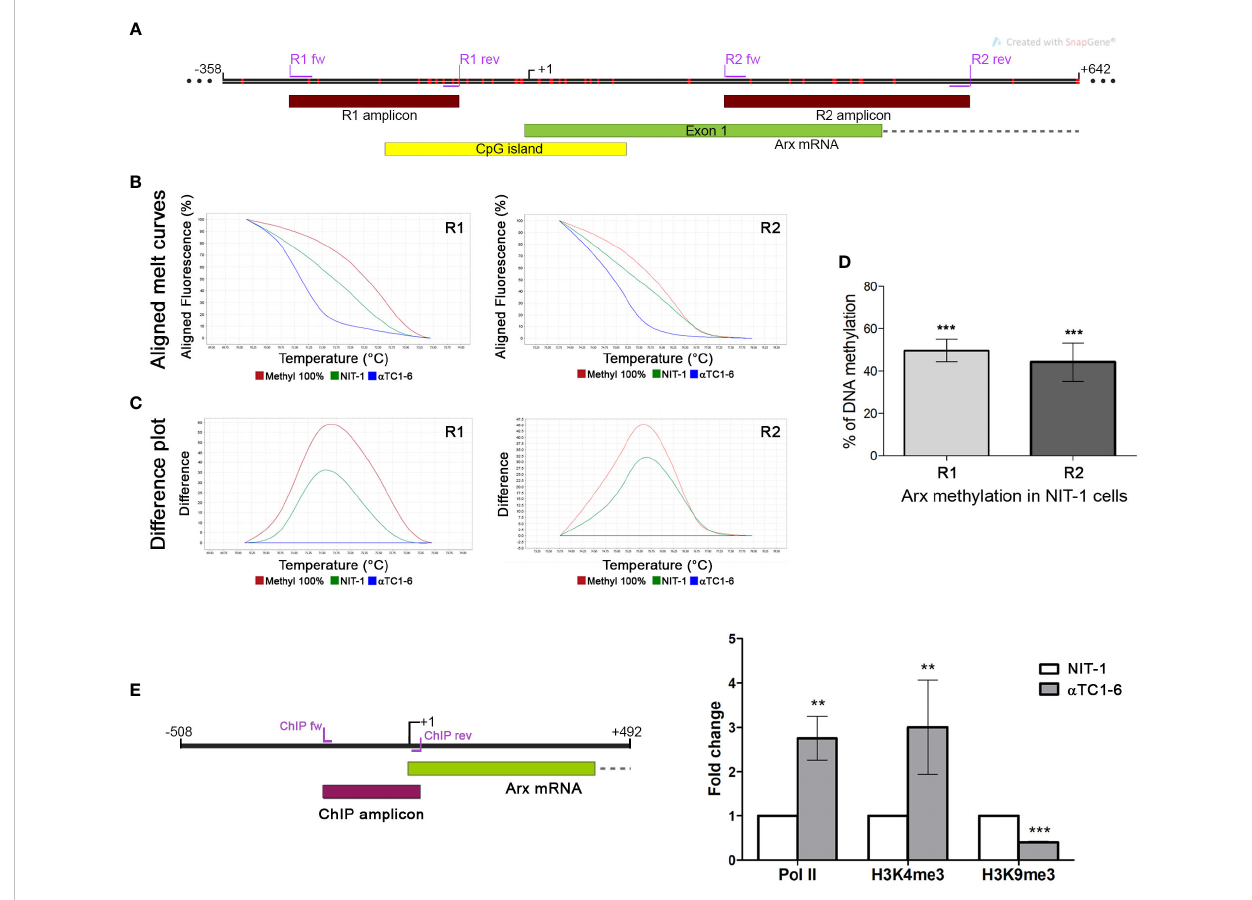
FIGURE 3 Presence of different epigenetic signatures in the Arx promoter of a TC1-6 and NIT-1 cell lines. (A) Schematic representation of the Arx genomic region on chr. X with the positions of primers used for DNA methylation analysis shown as purple lines, analyzed parts of the gene shown as dark red boxes, the part of Arx mRNA shown as the green box and the position of CpG island shown as the yellow box in the insert. Red vertical lines represent CpG sites in the Arx gene. The fi gure was created with the SnapGene. (B) The representative aligned melting curves and (C) the difference plots obtained by HRM analysis show positions of NIT-1 curves considering a TC1-6 cells as a 0% standard and commercially methylated mouse DNA standards assumed to be 100% methylated. (D) The column chart represents the relative level of DNA methylation in NIT-1 cells in two analyzed regions of the Arx gene compared to a TC1-6 cells methylation level (N=3). The results are expressed as means ± SDs. For determining statistical signi fi cance the one sample t-test was used, ***p ≤ 0.001. (E) ChIP-qPCR analysis of RNA pol II, H3K4me3, and H3K9me3 histone modi fi cation occupancy at the Arx promoter region (ChIP amplicon) in a TC1-6 and NIT-1 cell lines. ChIP was performed with antibodies against RNA pol II, H3K4me3 and H3K9me3 (N=3). The immunoprecipitated chromatin fragments were analyzed by quantitative PCR using primers for the Arx promoter sequence in a TC1-6 and NIT-1 cell lines. The positions of primers used for chromatin ChIP analysis for the Arx are represented as purple lines. The results are expressed as means ± SDs. The Kolmogorov-Smirnov test (with D-W-L P value) was used for determining the normality of the ChIP sample. The one sample t-test was used for determining statistical signi fi cance values with normal distribution. For data with non- normal distribution, the Wilcoxon Signed Paired test was applied, **p ≤ 0.01, ***p ≤